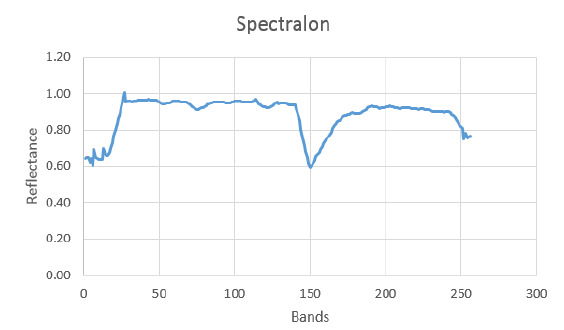
Figure 9. Spectral signature of the reference white